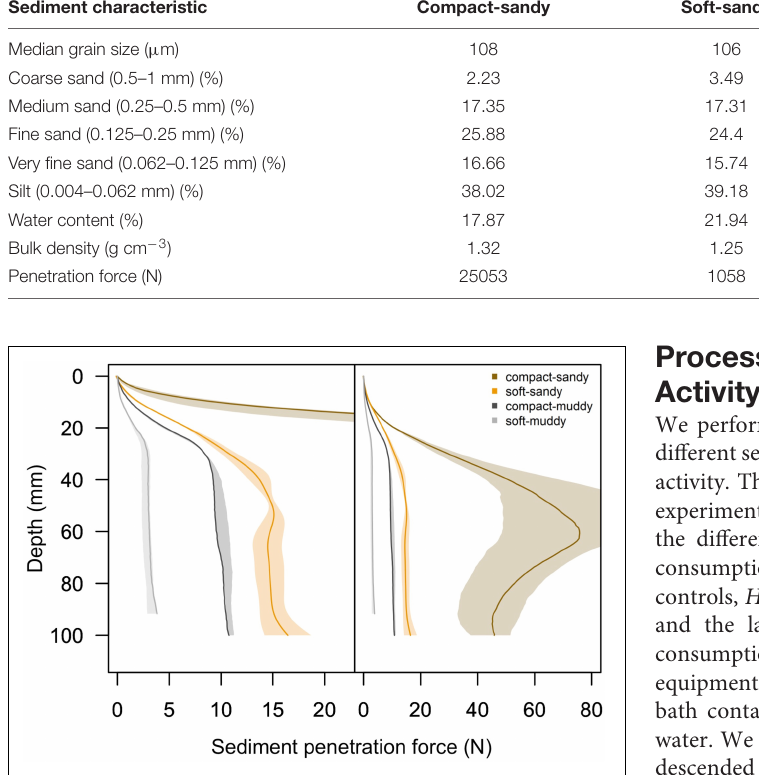
FIGURE 2 | Mean sediment penetration force profiles and 95% confidence intervals as measured by the universal testing machine for the four sediment treatments, with 95% confidence intervals encompassing the beginning and end of the experiment. We present a panel with a reduced x-axis scale on the left to show the details of the soft-sandy, compact-muddy, and soft-muddy sediment teatments, and we present a panel with a full x-axis scale on the right to show the extent of the compact-sandy sediment profile. Note that the penetration force of the compact-sandy treatment is an order of magnitude greater than the other three treatments and that in the right plot the profile for the compact-sandy sediment is scaled to 1/5 of the original sediment penetration force to fit into the plotting